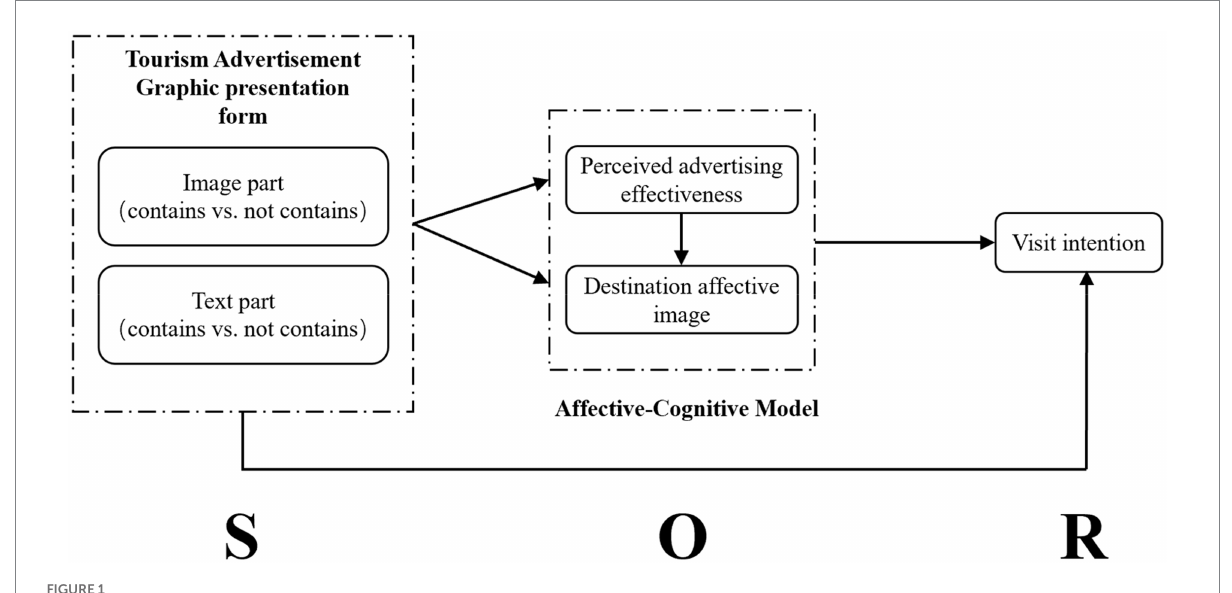
FIGURE 1 Theoretical framework. Source: Drawn by the author.